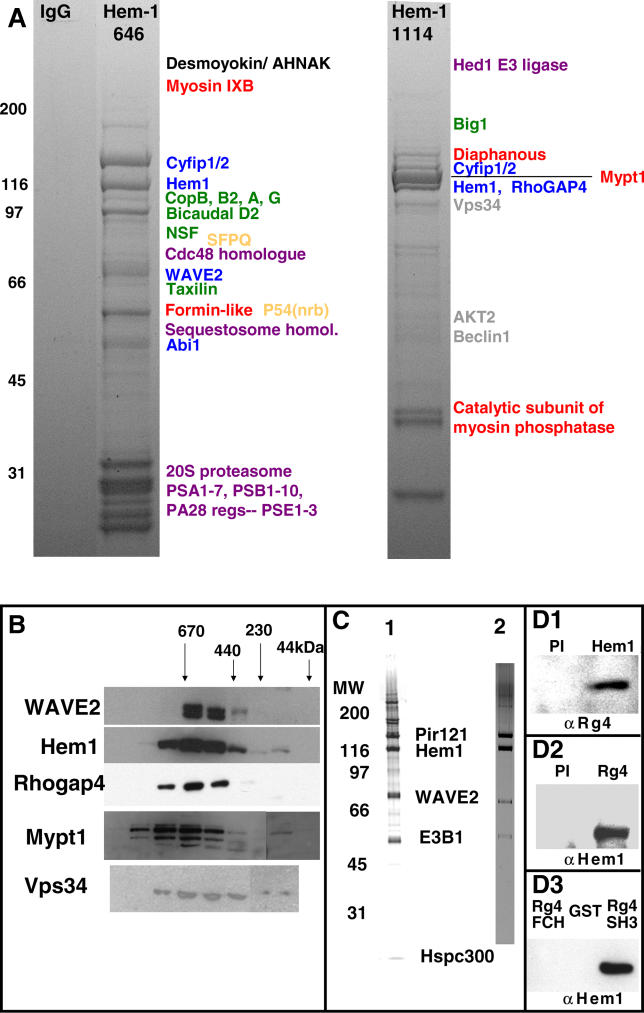
Antibodies to the Hem-1 Component of the WAVE Regulatory Complex Immunoprecipitate Potential Polarity Effectors in Addition to the WAVE2 Complex(A) Two milliliters of neutrophil-like differentiated HL-60 lysate (containing 10 mg of protein) were immunoprecipitated with one of two Hem-1 antibodies, raised against an internal region of Hem-1 (646–659) or the C-terminus of Hem-1 (1114–1127), and eluted with the corresponding peptides. The same immunoprecipitation and elution were performed with purified rabbit IgG as a control. The gel was stained with Gelcode Blue. Mass spectrometry–based protein IDs are noted at approximate gel slice position. Colors of proteins indicate major functional classes. Blue, expected components of WAVE2 complex; red, regulators of actin and myosin; green, proteins implicated in vesicle or mRNA trafficking; gray, proteins implicated in lipid signaling; yellow, splicing factors; and purple, proteins implicated in protein degradation.(B) Several of the proteins that coimmunoprecipitate with Hem-1 run as large protein complexes. Crude HL-60 lysate was analyzed by gel filtration on Superose 6 and blotted with antibodies to Hem-1, WAVE2, RhoGAP4, the regulatory subunit of myosin light chain phosphatase (Mypt1), or Vps34 (class III PI3K). The positions of molecular weight standards (thyroglobin, ferritin, catalase, and albumin) are noted.(C) Silver-stained SDS-PAGE of Superose 6 peak of conventionally purified native pig leukocyte WAVE2 complex, including protein identifications (C1). All proteins were identified via mass spectrometry with the exception of Hspc300. Alternatively, antibodies to Hem-1 (646–659) were used to immunoprecipitate the WAVE2 complex from the Superose 6 WAVE2 peak to unambiguously distinguish WAVE2 components from remaining contaminants (C2). Besides the expected core components of the WAVE2 complex, no other Hem-1–associated proteins were identified via mass spectrometry in the purified native pig leukocyte WAVE2 complex.(D) Endogenous Hem-1 and RhoGAP4 reciprocally immunoprecipitate. (1) HL-60 lysates were immunoprecipitated with either Hem-1 or preimmune antisera, eluted, and blotted with RhoGAP4 antibodies. RhoGAP4 signal represents approximately 1% of input. (2) HL-60 lysates were immunoprecipitated with either RhoGAP4 or preimmune antisera, eluted, and blotted with Hem-1 antibodies. Hem-1 signal represents approximately 1% of input. (3) The SH3 domain of RhoGAP4 is sufficient for interaction with Hem-1. GST-tagged RhoGAP4 SH3 was incubated with HL-60 lysate, eluted with glutathione, and blotted for Hem-1. The FCH domain of RhoGAP4 and GST alone fail to pull down Hem-1 from lysates.